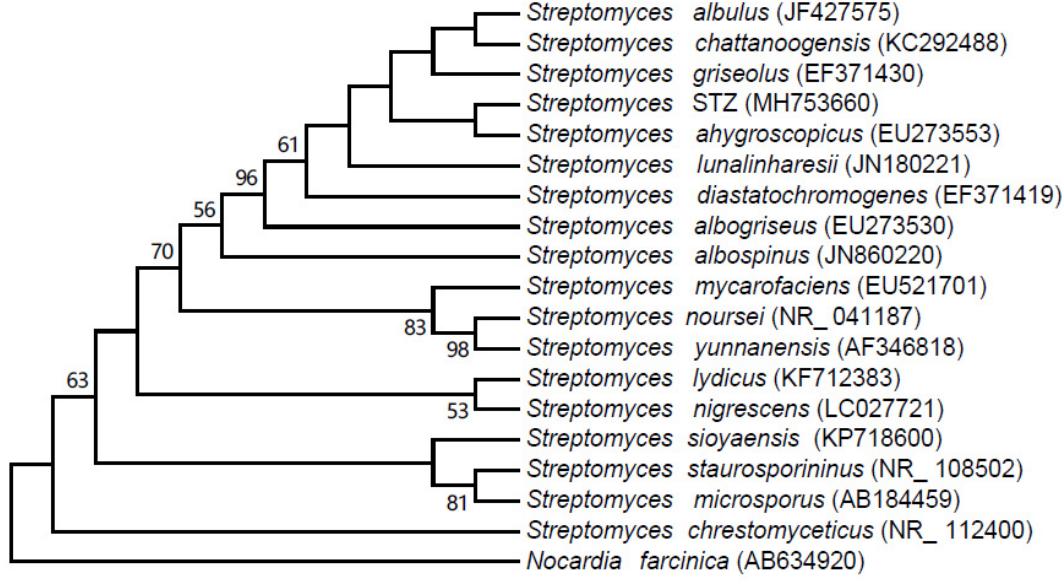
Figure 2. Phylogenetic analysis based on 16S rRNA gene sequences of Streptomyces STZ and species of the genus Streptomyces using the maximum likelihood method. Numbers on branch nodes are bootstrap values (1000 replicates).